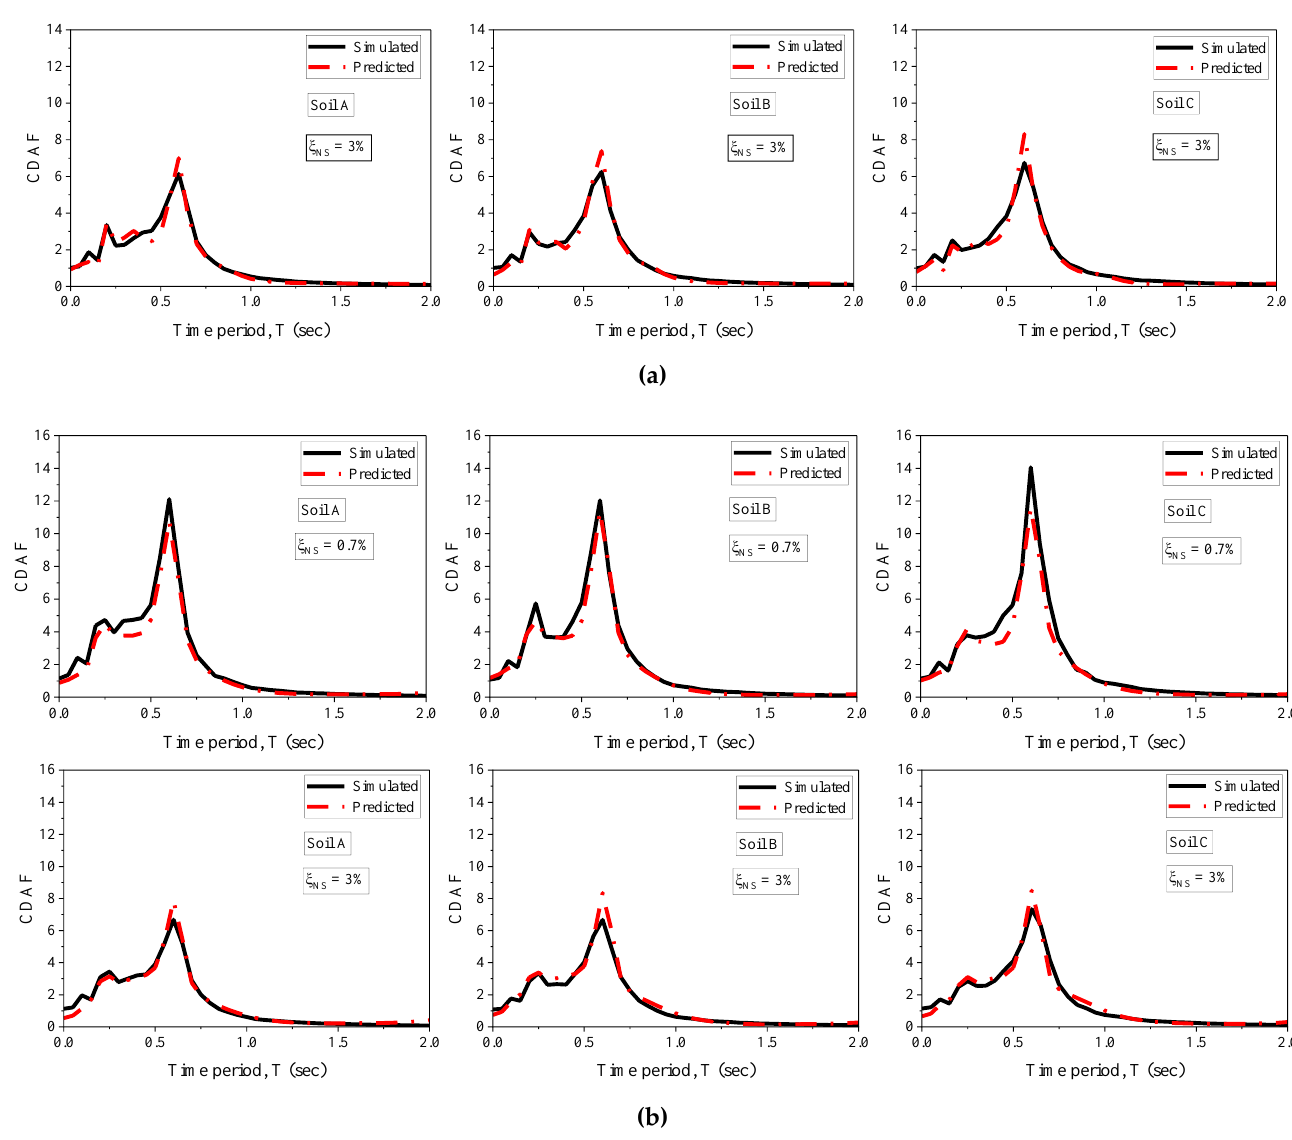
Figure 19. Top floor s imulated and ANN’s predicted CDAF spectra : ( a ) regular model; ( b ) irregular model.